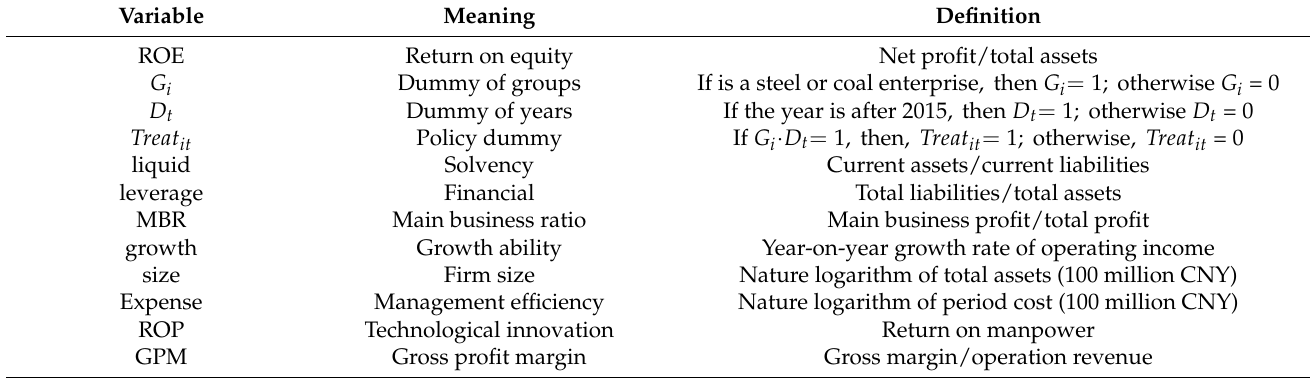
Table 1. Definitions of variables.